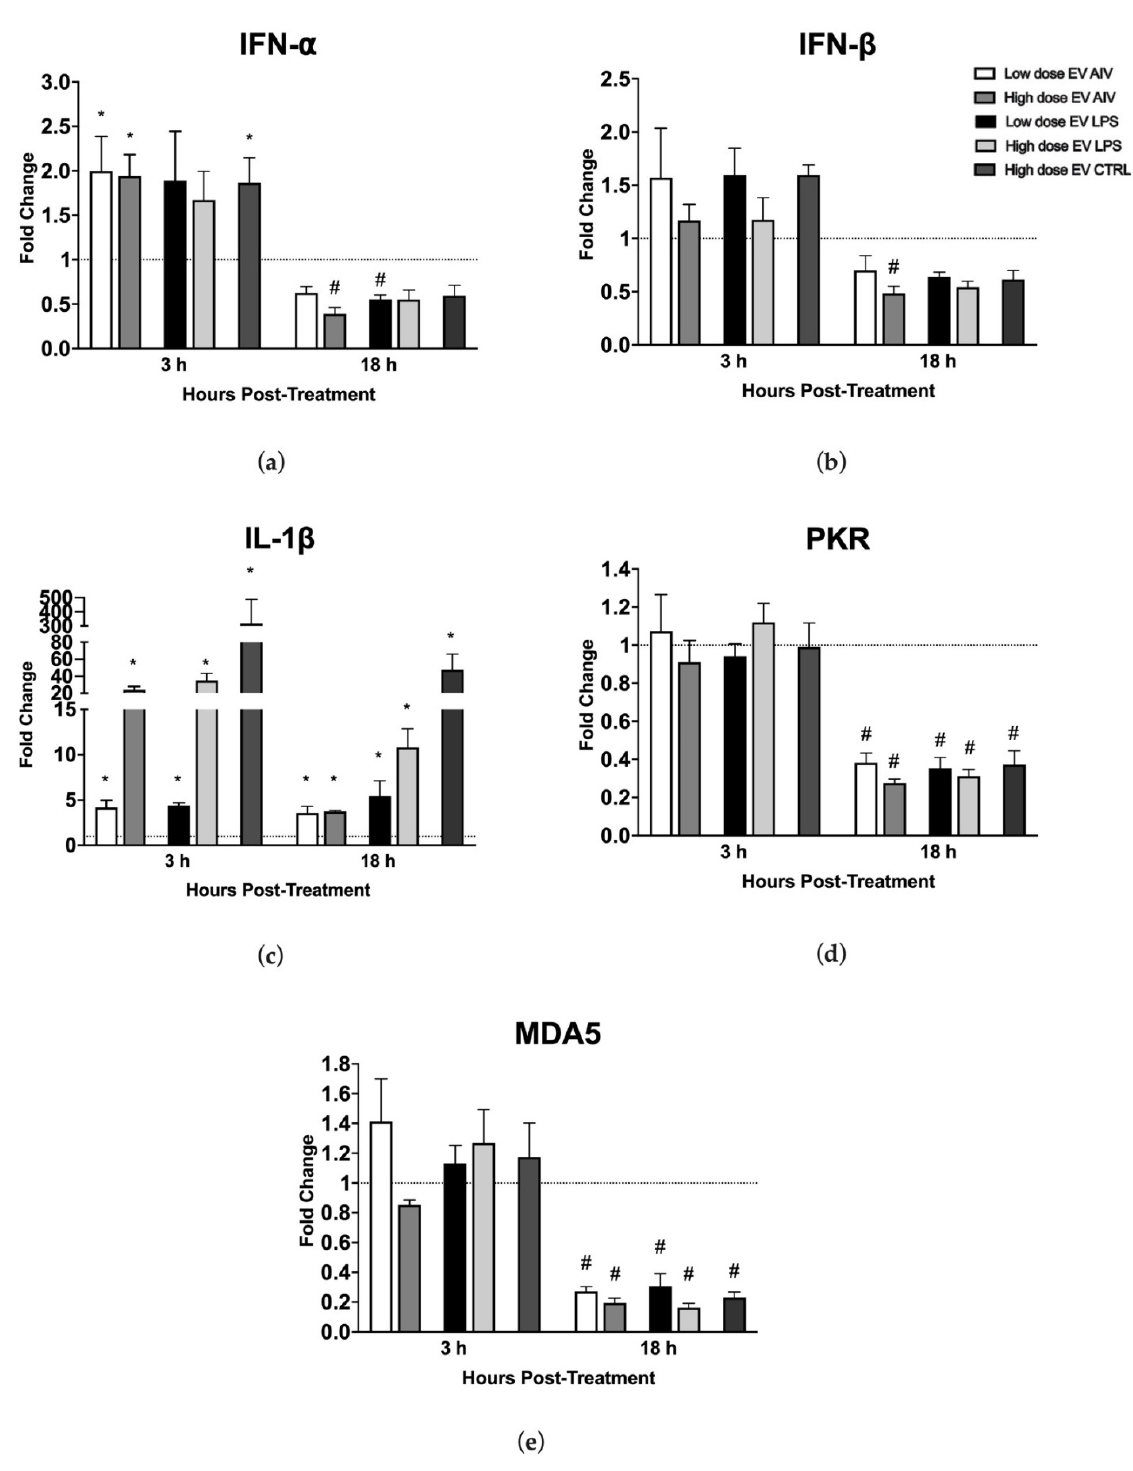
Figure 8. Relative gene expression of chicken macrophages stimulated with EVs. Macrophages were treated with a low dose (5 µg/mL) or a high dose (25 µg/mL) of EVs and collected at two different timepoints, 3 h and 18 h post-stimulation. The relative gene expression of IFN- α ( a ), IFN- β ( b ), IL-1 β ( c ), PKR ( d ), and MDA5 ( e ) was measured by RT-qPCR. Treatment groups with significant up-regulation ( p -value < 0.05) are represented by *, whereas treatment groups with significant down-regulation ( p -value < 0.05) are represented by #. The error bars represent the standard error of mean (SEM).